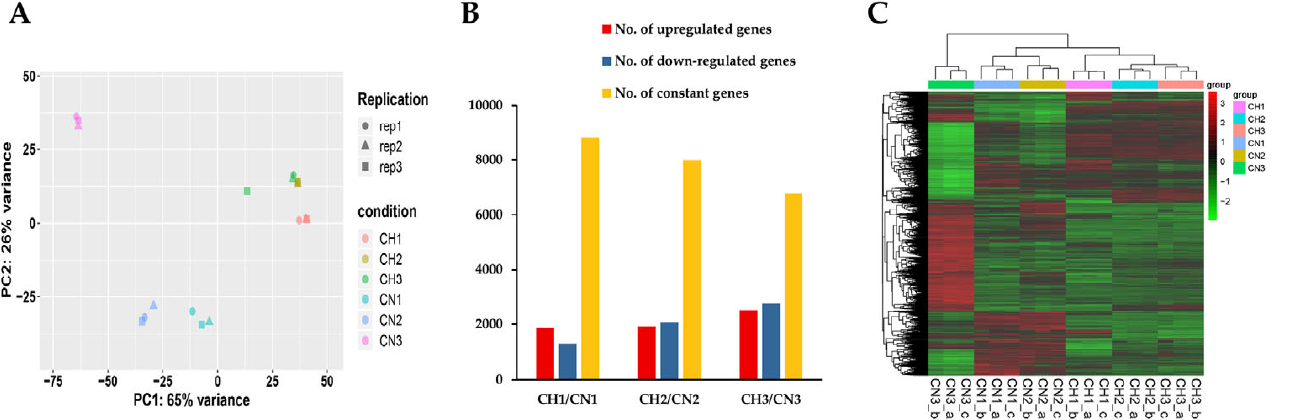
Figure 1. RNA expression differences of T. asperellum GDFS 1009 in liquid shaking culture and solid surface culture at different growth stages. CH1/2/3 and CN1/2/3 represent liquid shaking culture and solid surface culture at 48, 72, and 96 h, respectively. ( A ) Principal component analysis (PCA) of different samples. ( B ) Differentially expressed genes (DEGs) numbers of liquid shaking culture compared to solid surface culture. ( C ) Heat map of all the DEGs and the complete linkage method was used for cluster analysis.